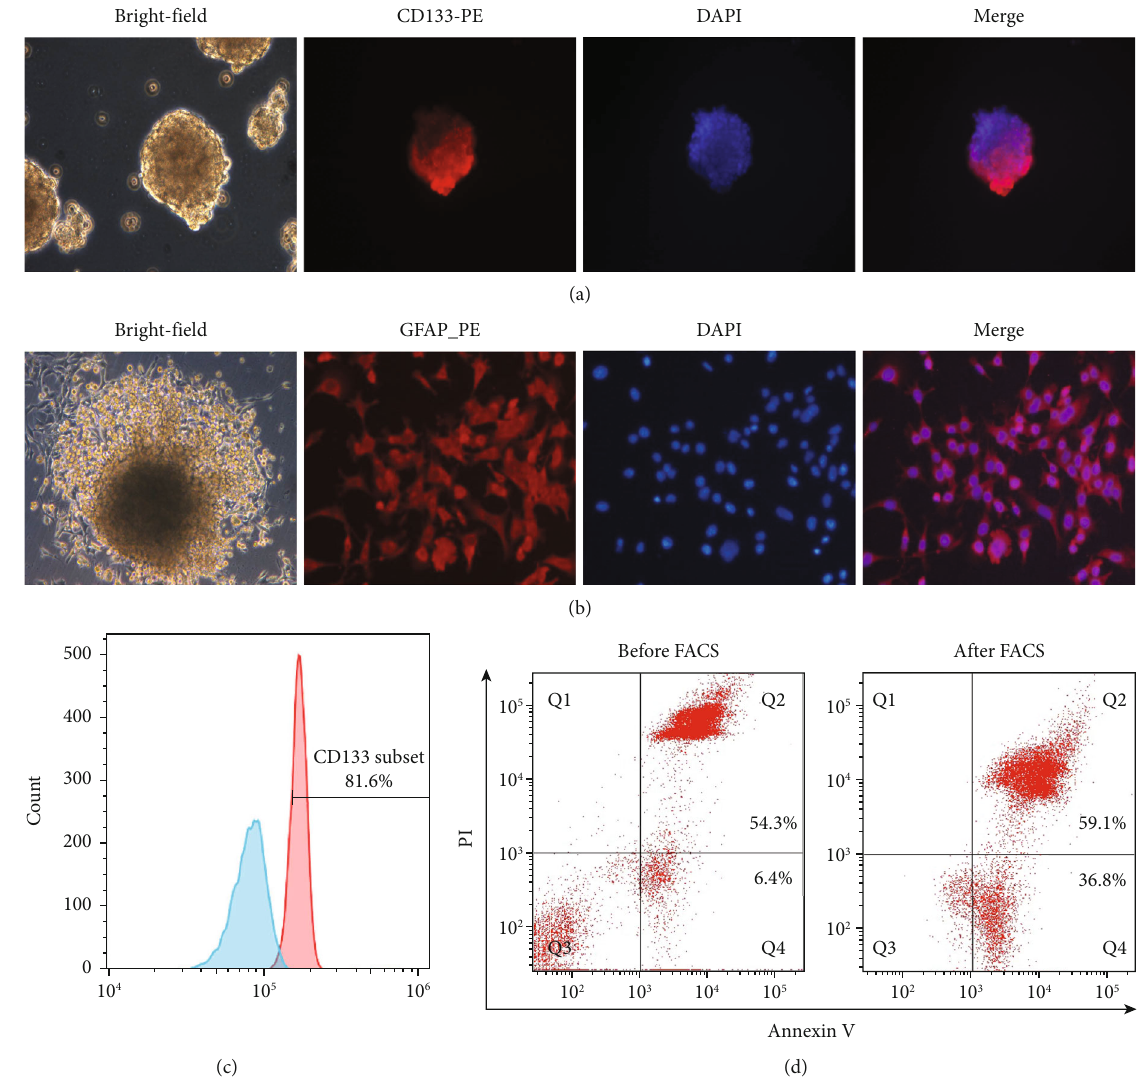
Figure 1: Characterization of GL261-induced cancer stem cells. (a) Tumour spheres expressing CD133 and DAPI. (b) After 3 days of culture in FBS-containing medium, spheres began to spread into adherent monolayers cells. (c) The results of fl ow cytometry of tumour spheres at the third passage. Red and blue pro fi les, respectively, represent test group and negative control; number indicates percentage of CD133+ cells. (d) The apoptosis rate was 54 : 3 % + 6 : 4 % before FACS, and 59 : 1 % + 36 : 8 % after FACS (Q3 and